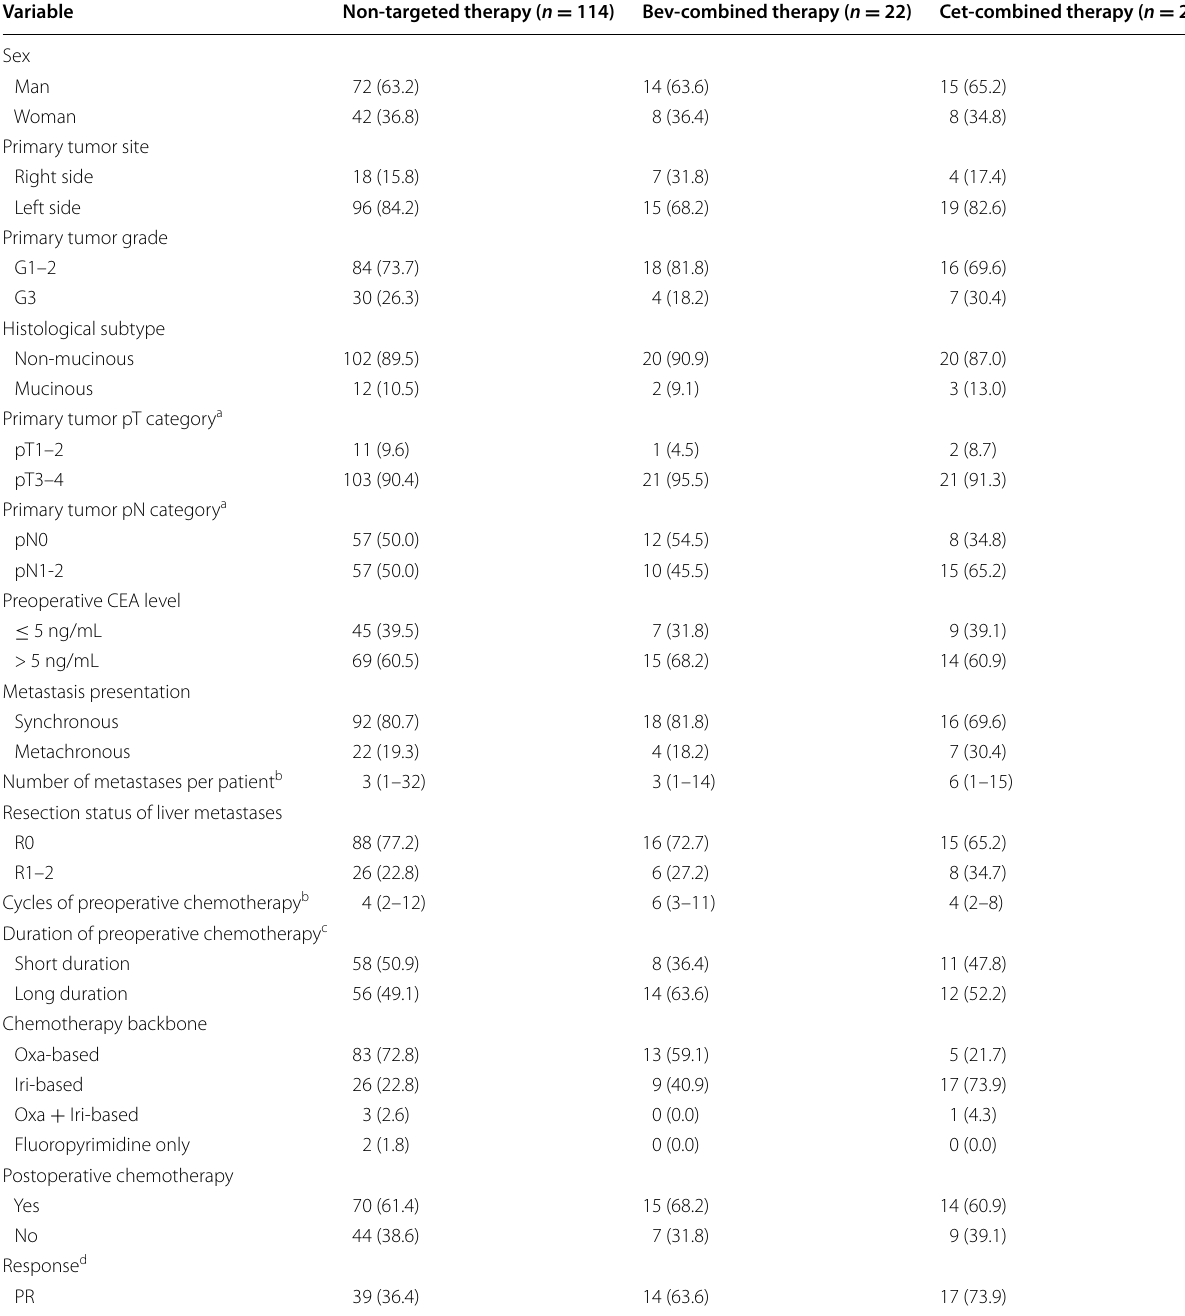
Table 1 Clinicopathologic characteristics of colorectal cancer patients with liver metastases according to preoperative